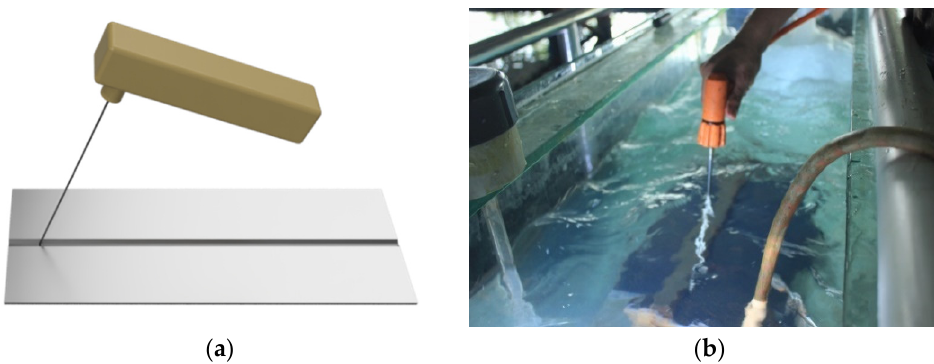
Figure 6. ( a ) Systematics of welding, ( b ) position of the welding arc during the welding process.